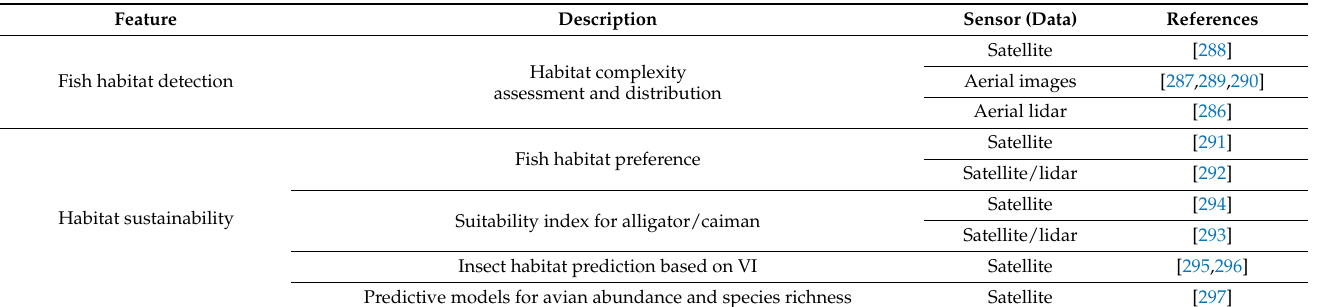
Table 6. Wildlife habitat status assessment using RS technologies. Studies are sorted based on a short description of the methodologies and sensors